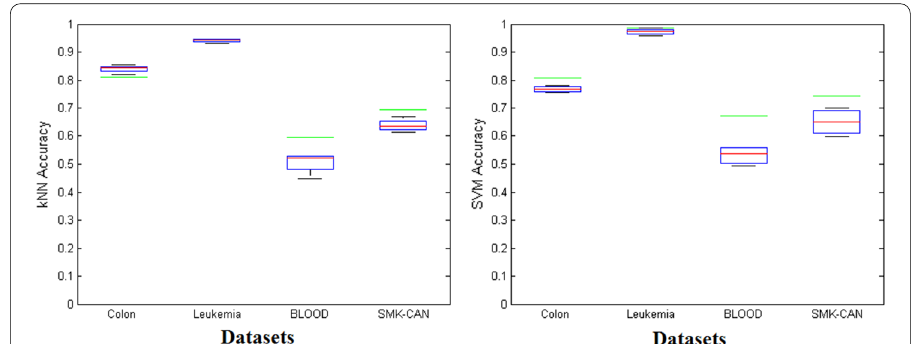
Fig. 8 Accuracy evaluation of Fisher Score using KNN and SVM. Green line represents bagging while black lines, Red line and Blue box represent maximum, minimum, median and quartile of baseline performance respectively